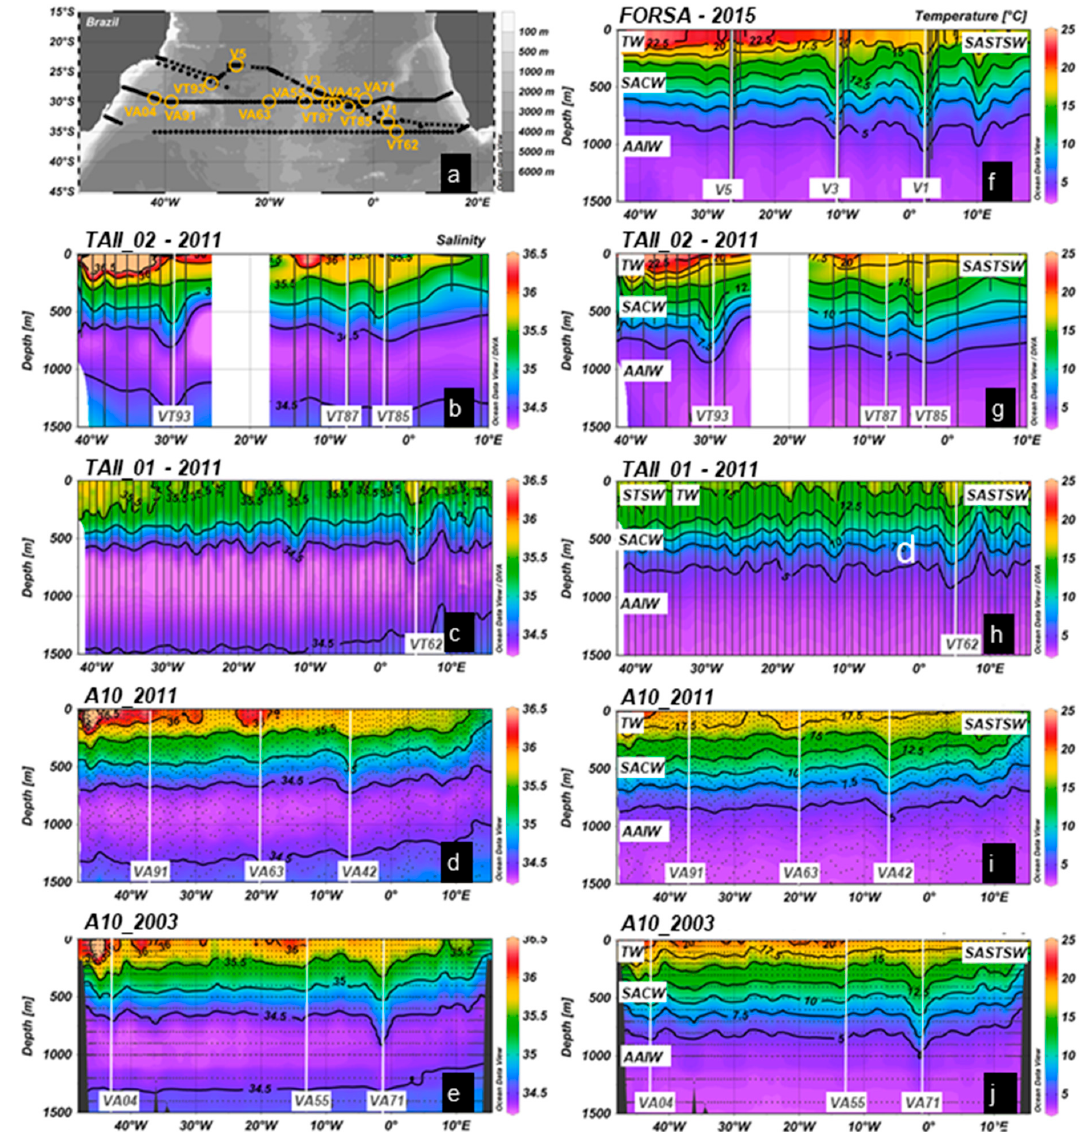
Figure 2. Map of the cruise sections and sampled eddies ( a ). For a complete description of this map, please see Figure 1. Left panels show the salinity profiles ( b – e ), while right panels show potential temperature (°C; f – j ) profiles. The hydrographic sections are TAII_02–2011 ( b , g ), TAII_01–2011 ( c , h ), A10_2011 ( d , i ) and A10_2003 ( e , j ). The continuous gray lines or gray dots indicate the position of the CTD stations (at each 1 m for the TAII and FORSA cruises). Temperatures from the XBT of the FORSA–2015 cruise section and CTD stations are indicated by continuous gray lines ( f ). The sampled eddies are indicated in the hydrographic sections of all cruises by vertical white lines. The water mass positions in the water column are indicated by their acronyms in panels f to j , referring to: Subtropical Shelf Water (STSW), Tropical Water (TW), South Atlantic Subtropical Surface Water (SASTSW), South Atlantic Central Water (SACW), and Antarctic Intermediate Water (AAIW). For details, please see the θ /S diagrams (Figure 3) and the water masses properties (Table 3).